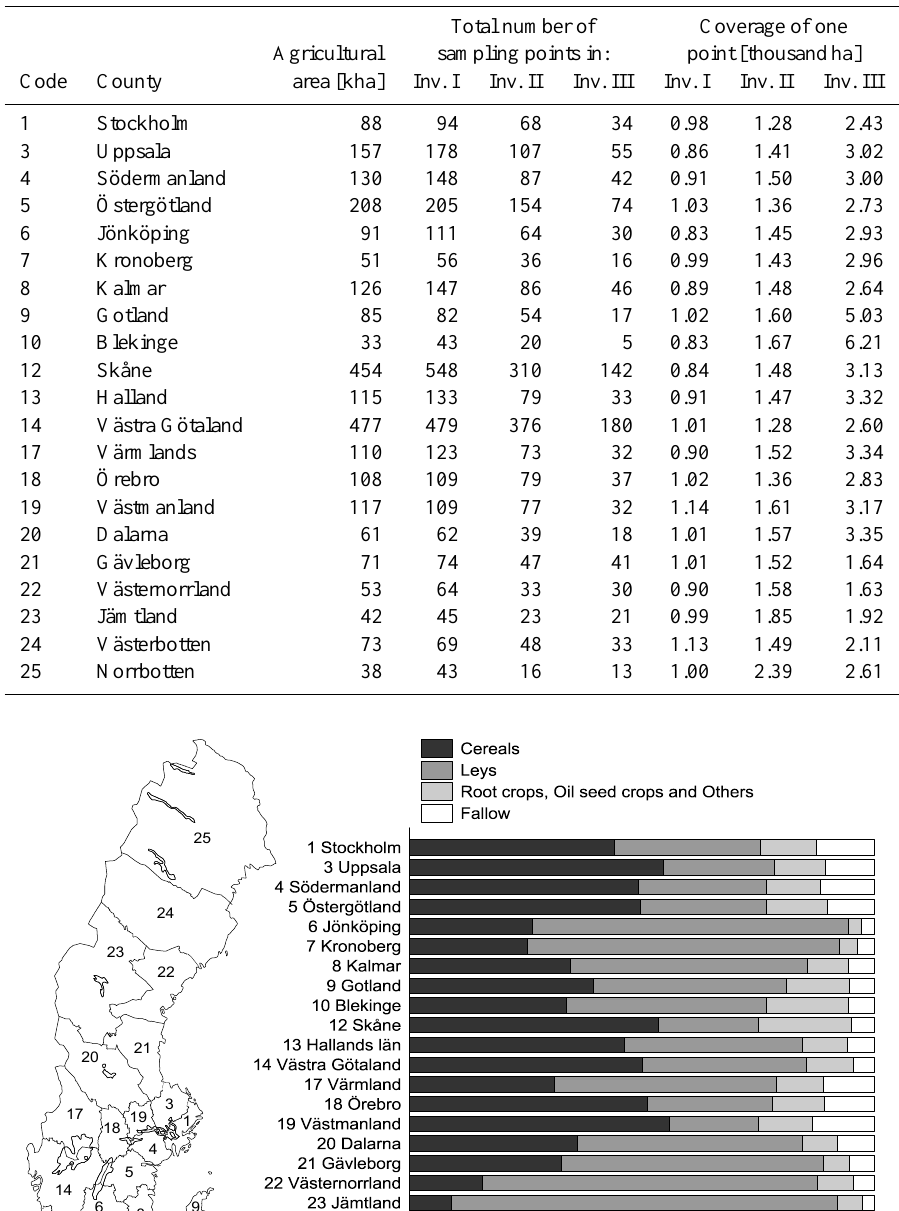
Table 1. List of Swedish counties and their average agricultural area since the start of the inventories (1988), total number of sampling points used in Inventories (Inv.) I, II and III and the coverage of one sampling point in each inventory.